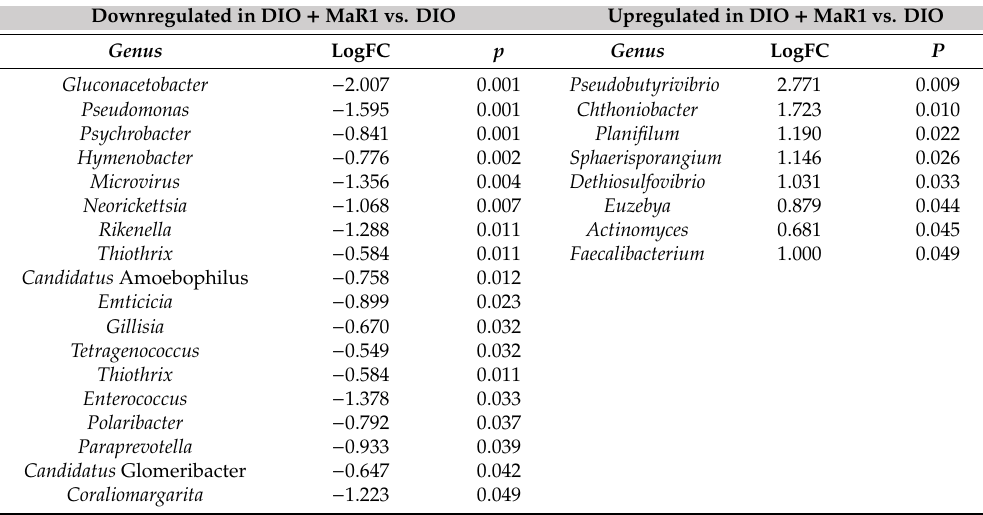
Table 1. Di ff erential bacterial taxonomic profile at the genus level in the DIO + MaR1 vs. The DIO mice. Downregulated in DIO + MaR1 vs. DIO Upregulated in DIO + MaR1 vs. DIO Genus LogFC p Genus